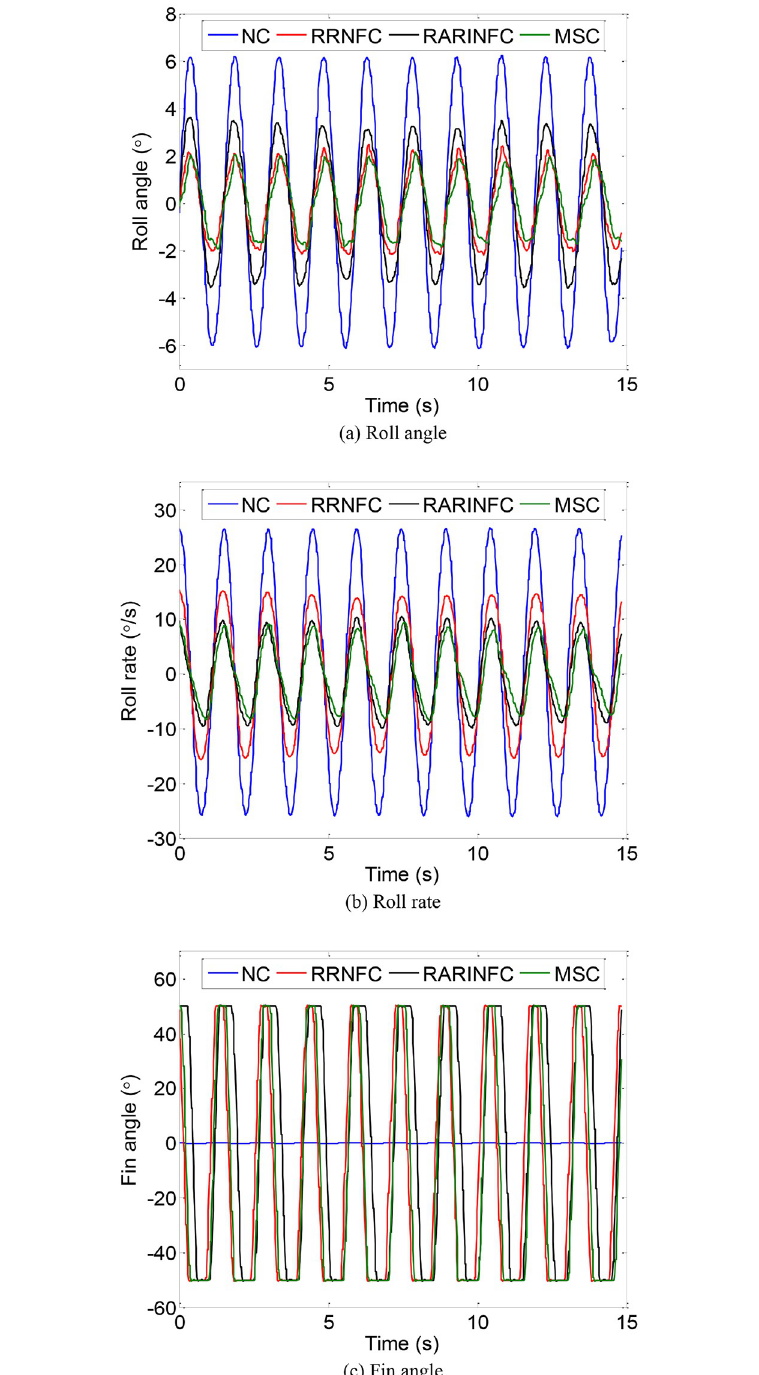
Fig 13. Roll motion of the scaled ship model without and with control. (a) Roll angle. (b) Roll rate. (c) Fin angle.